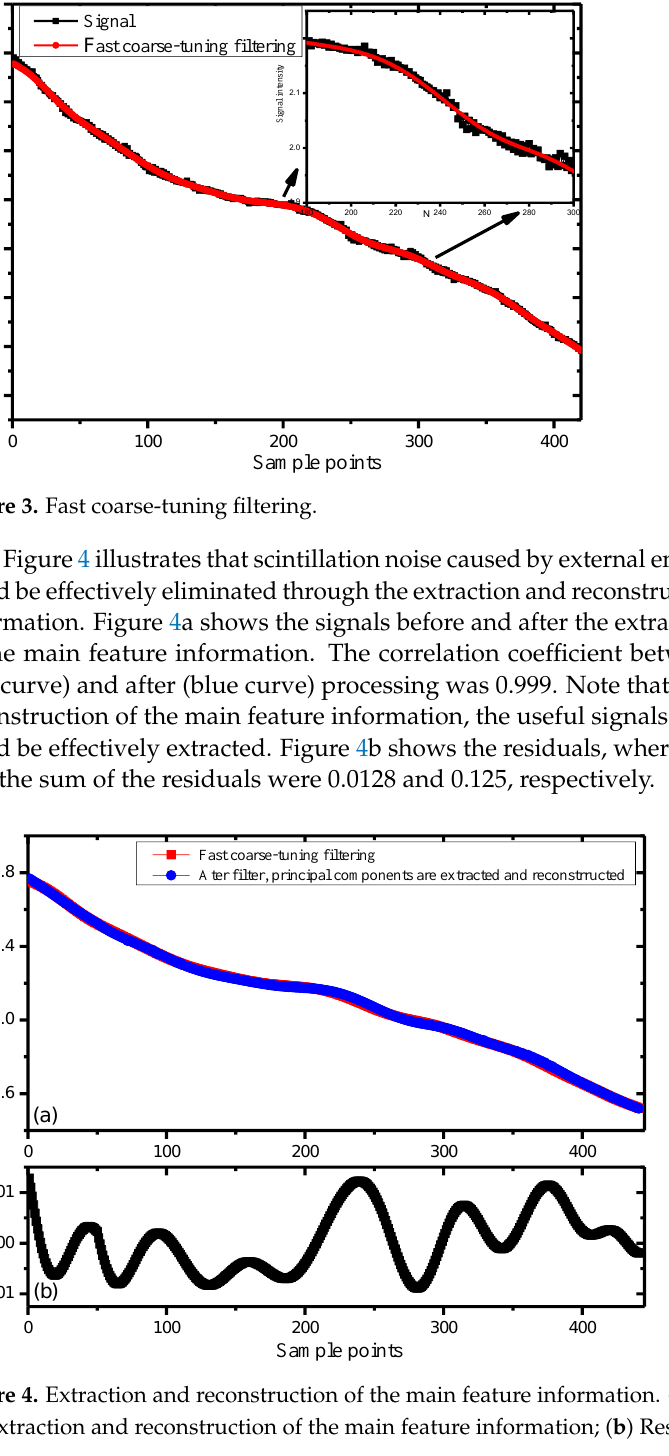
Signal Traditional fitting Proposed method for fitting R e s i du a l Figure 5. Background signal fitting: ( a ) background signal fitting and ( b ) residual signals in the non- absorbed part. The proposed method and the traditional method [25] were used to remove the back- ground noise, as shown in Figure 6. Apparently, the proposed method (blue curve) sig- nificantly improved the signal quality after removing the background noise compared with the traditional method (red curve). In Figure 6, the red curve was obtained using the